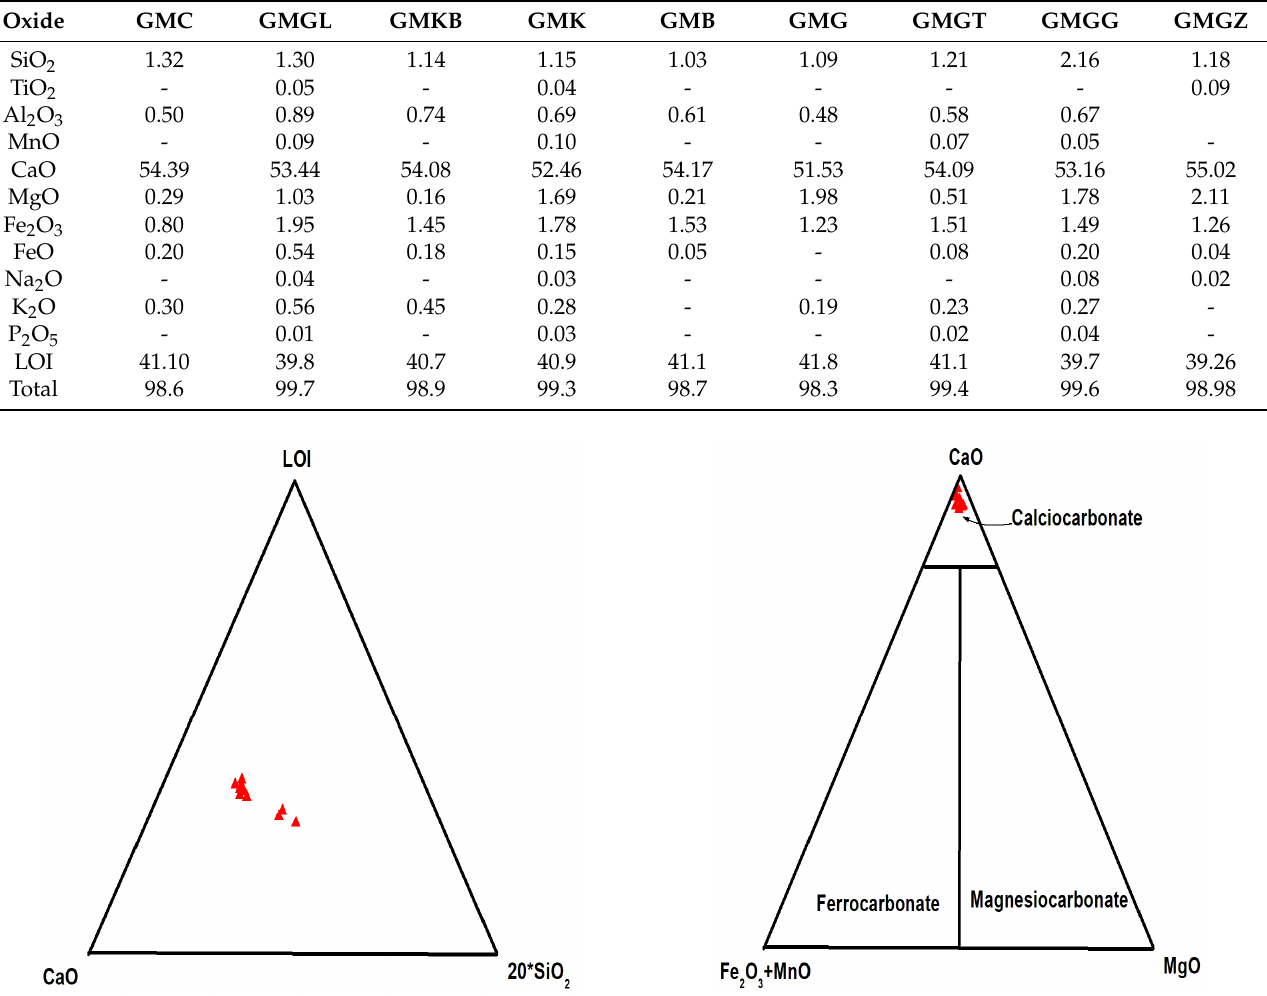
Figure 5. Ternary CaO–20*SiO 2 –LOI diagram depicting the relationship between the SiO 2 content and the CaO/LOI ratio ( Left ). Ternary discrimination diagram of carbonated samples in the fields of calciocarbonate, ferrocarbonate and magnesiocarbonate ( Right ) (after Woolley and Church [48]).